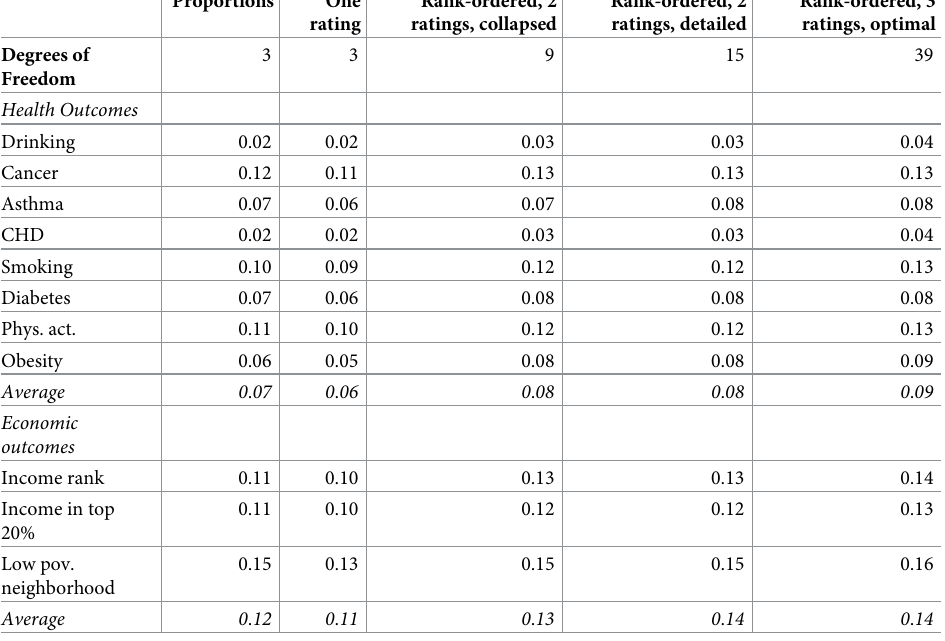
Table 5. R-squared statistics from OLS regressions of 11 census tract level health and socio-economic outcomes on different census tract HOLC rating measures/classifications. Proportions One Rank-ordered, 2 Rank-ordered, 2 Rank-ordered, 3 rating ratings, collapsed ratings, detailed ratings,